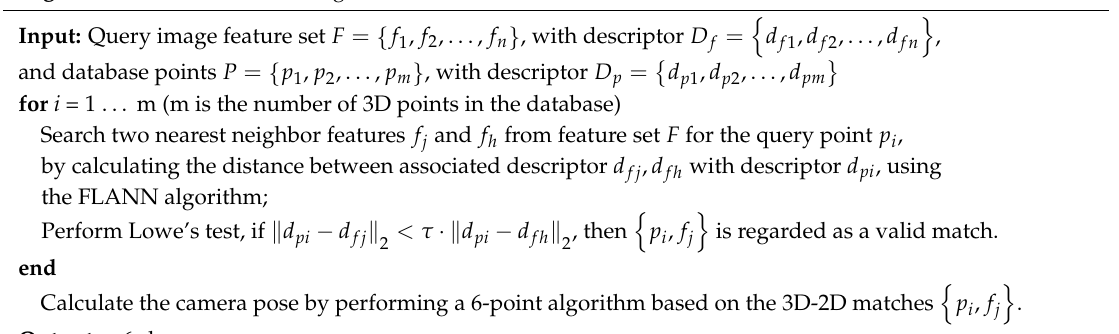
Algorithm 2. 3D-to-2D matching